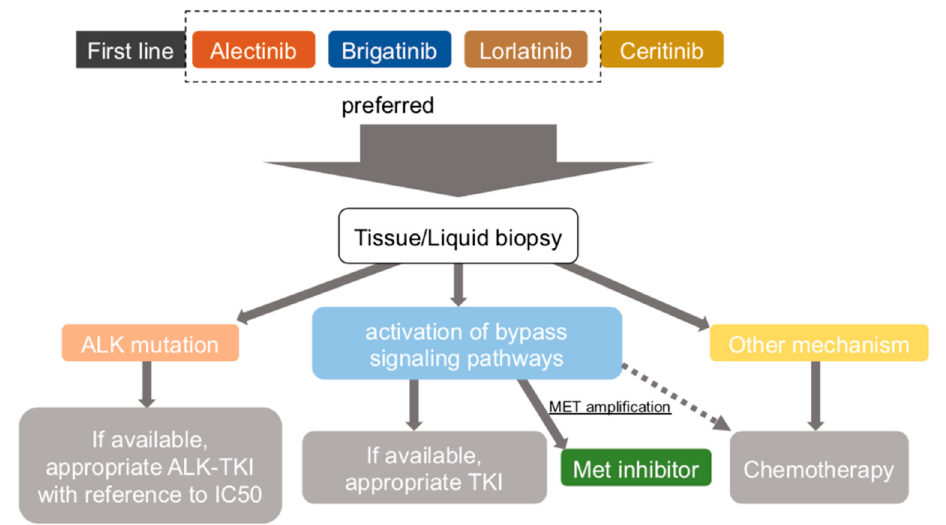
Figure 2. Proposed treatment algorithm for ALK-rearranged advanced NSCLC.